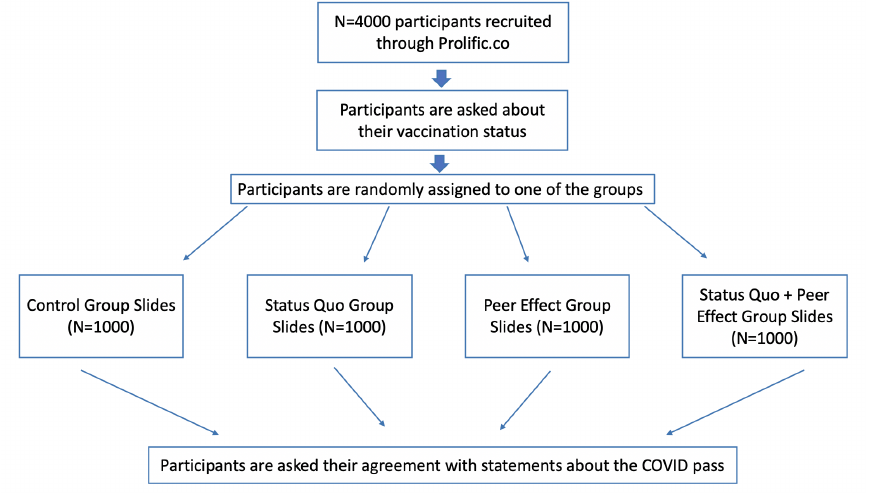
Figure 2. Experiment